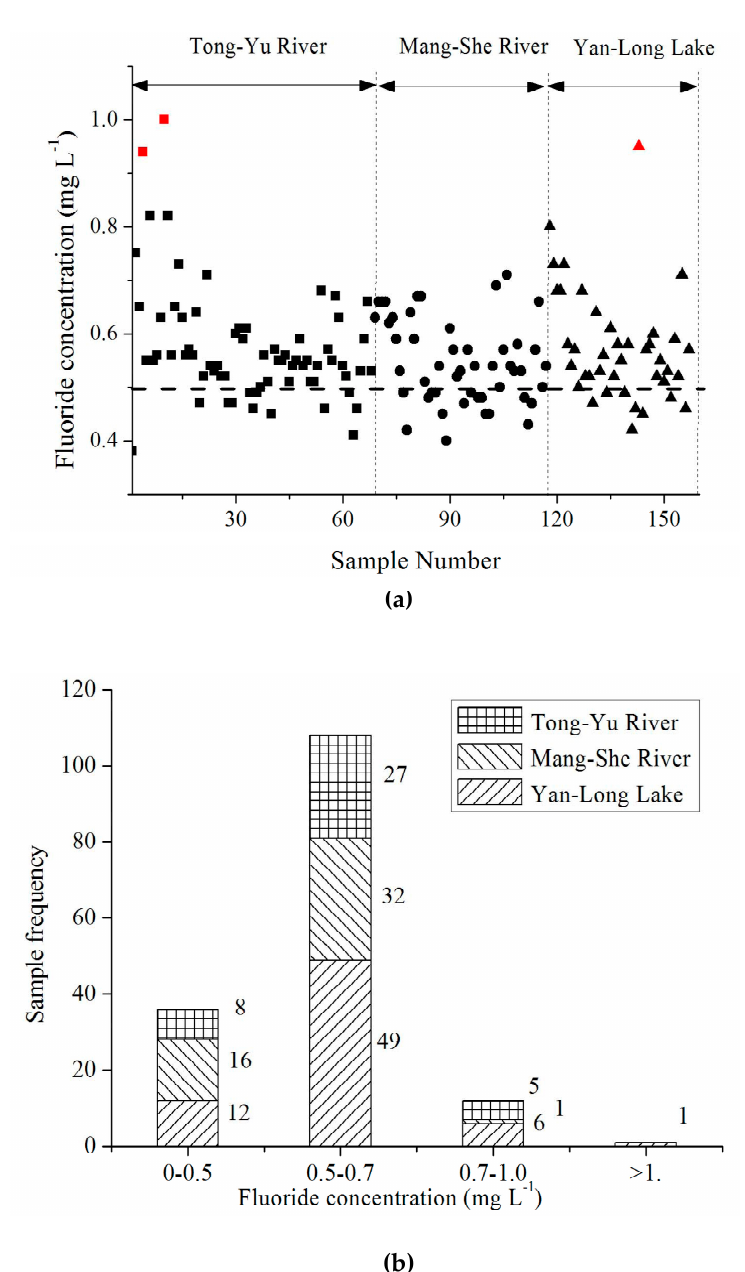
Figure 3. Fluoride contents and frequency distribution in drinking water sources of Yancheng City ( a ) Fluoride contents in drinking water sources of Yancheng City. Note: Dashed line refers to fluoride concentration of 0.5 mg L − 1 , which is the limit to prevent tooth cavity recommended by the WHO. ( b ) Frequency distributions of fluoride concentration in the studied area.